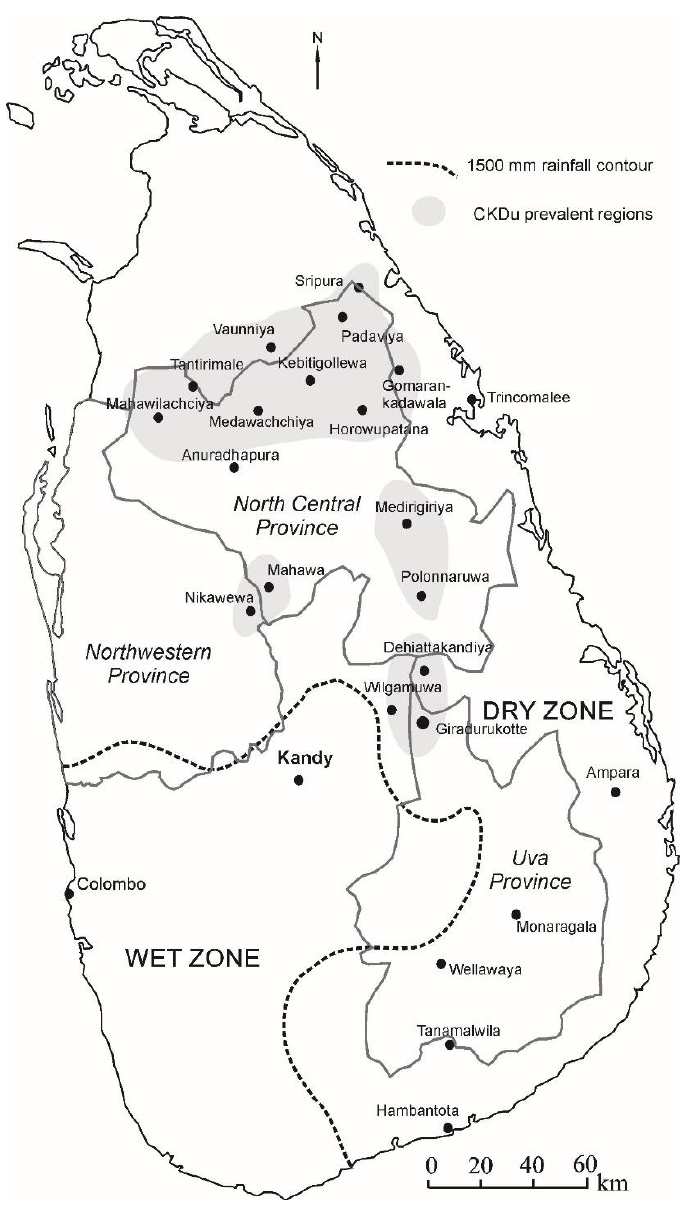
Figure 1: Distribution of Chronic Kidney Diseases with uncertain etiology (CKDu) in the dry zone of Sri